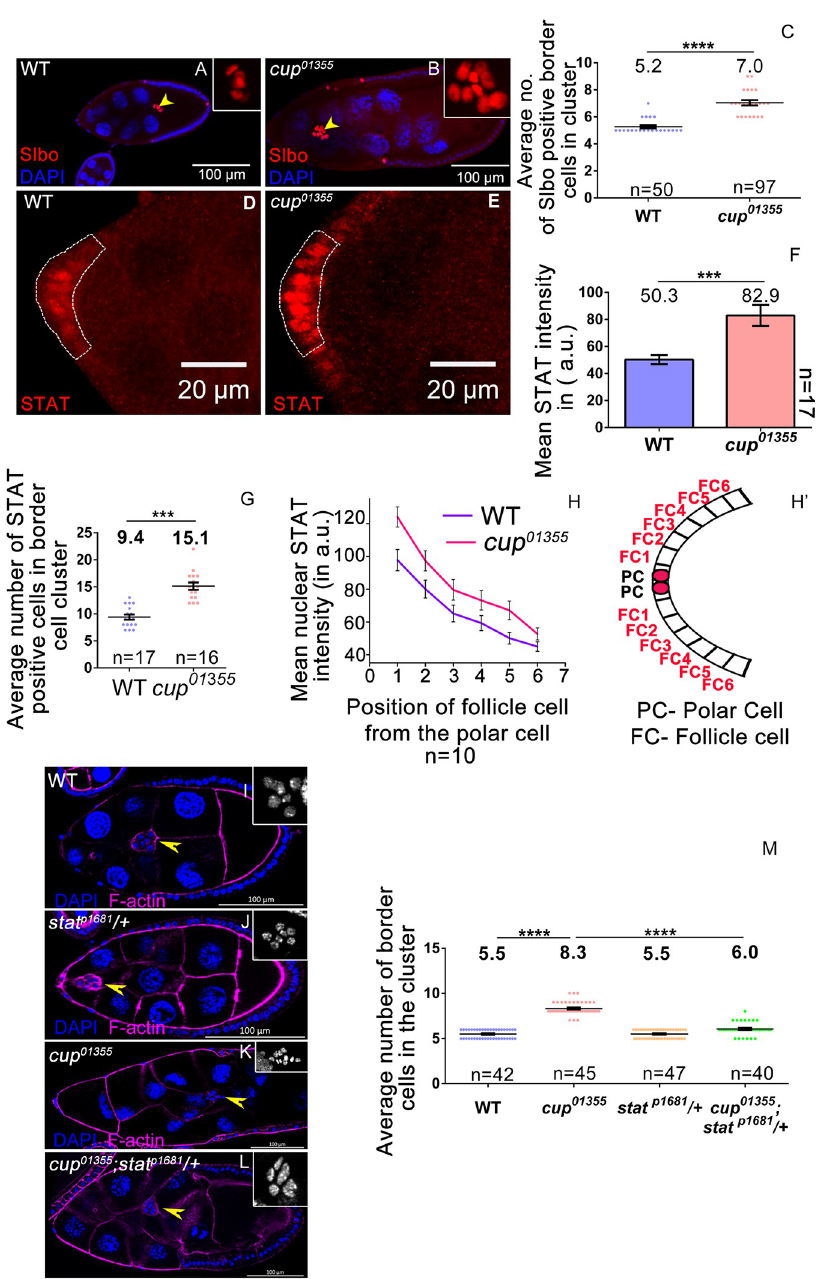
Fig 2. Cup modulates STAT in the follicle cells to limit BC fate. ( A-C ) cup 01355 egg chambers exhibit increased Slbo positive cells (yellow arrow head) compared to wild type, Slbo (red), DAPI (blue). ( D-G ) cup 01355 egg chambers exhibit higher STAT levels and more STAT positive cells in anterior end of egg chamber as compared to wild type (dotted area), STAT (red). ( H-H’ ) STAT level is higher in 6 th FC from polar cell in cup 01355 egg chambers as compared to control. ( I-M ) Higher BC numbers is rescued when stat p1681 /+ background is introduced in cup 01355 homozygous background (yellow arrow heads mark BC), F-actin (magenta), DAPI (blue, grey in inset). Student t-test, p value between WT and cup 01355 is < 0.0001 indicated by ���� , p value between cup 01355 and cup 01355 ; stat p1681 /+ is < 0.0001 indicated by ���� , p value between WT and cup 01355 ; stat p1681 /+ is < 0.0001 indicated by ���� . n represents the number of egg chambers evaluated. SEM represent the error